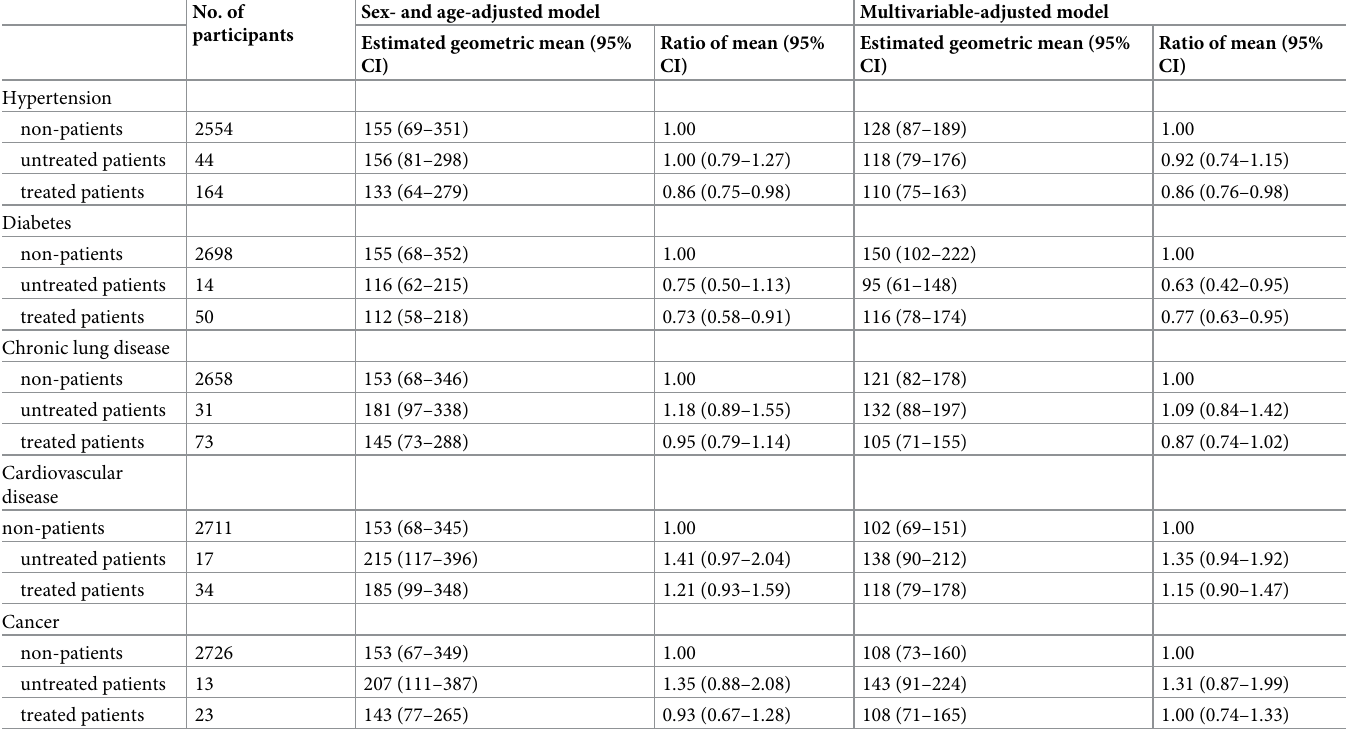
Table 2. Estimated geometric means and 95% confidence intervals for anti-SARS-CoV-2 spike IgG antibody titers according to the presence or absence of underly- ing medical conditions and treatments. No. of participants